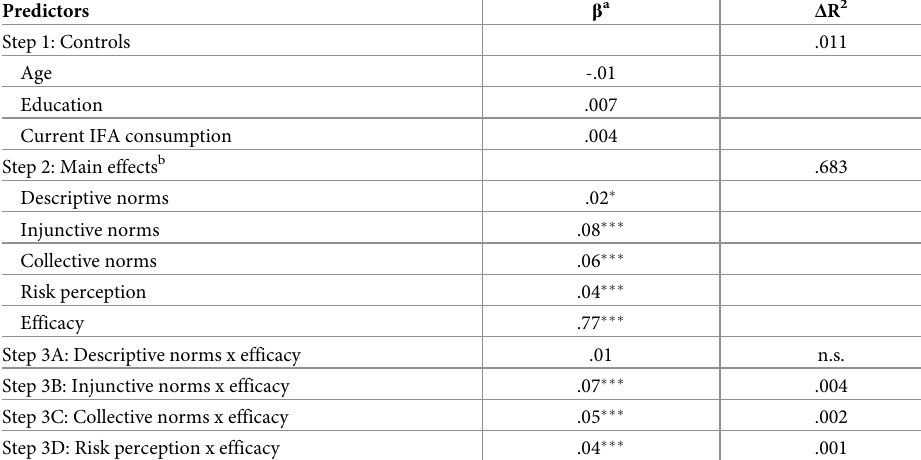
Table 2. Effects of norms, risk perceptions, and efficacy on intentions to consume iron and folic acid from regres- sion equations.